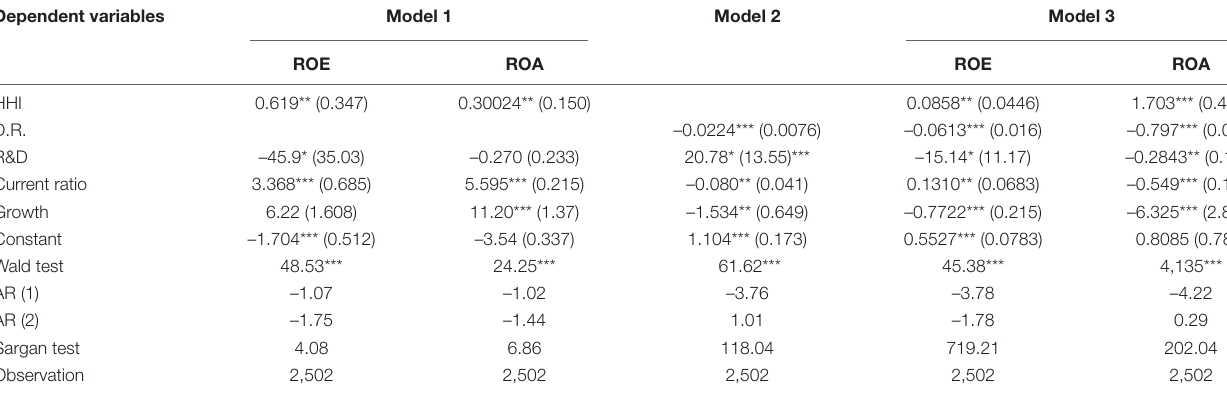
TABLE 2 | Market competition and firm performance: a mediating effect of capital structure.